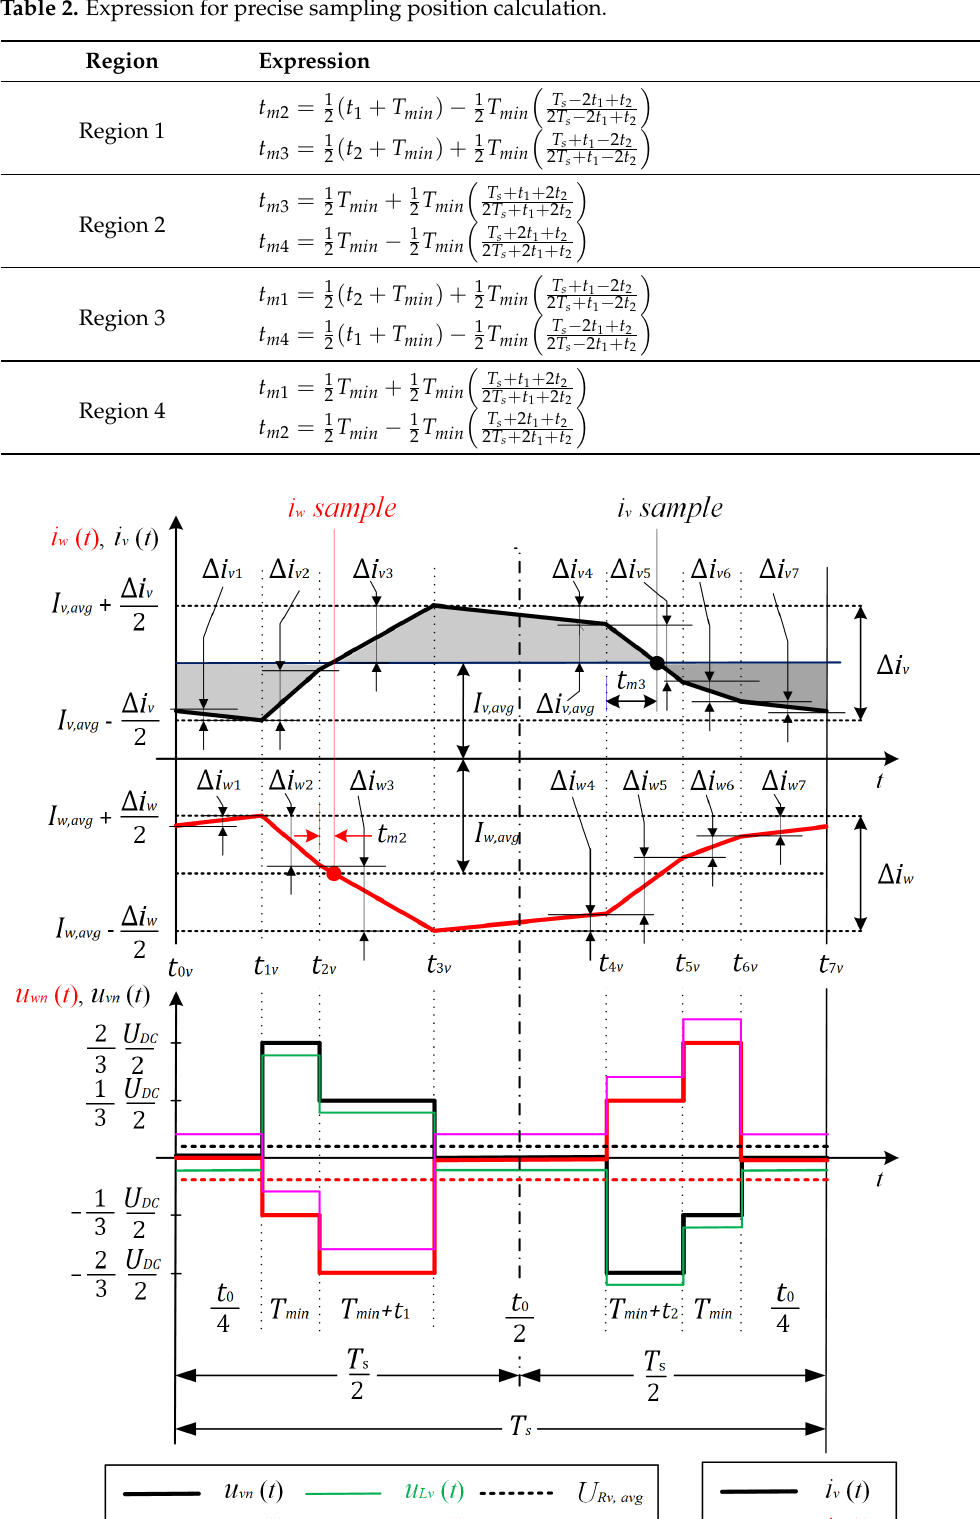
Table 2. Expression for precise sampling position calculation.